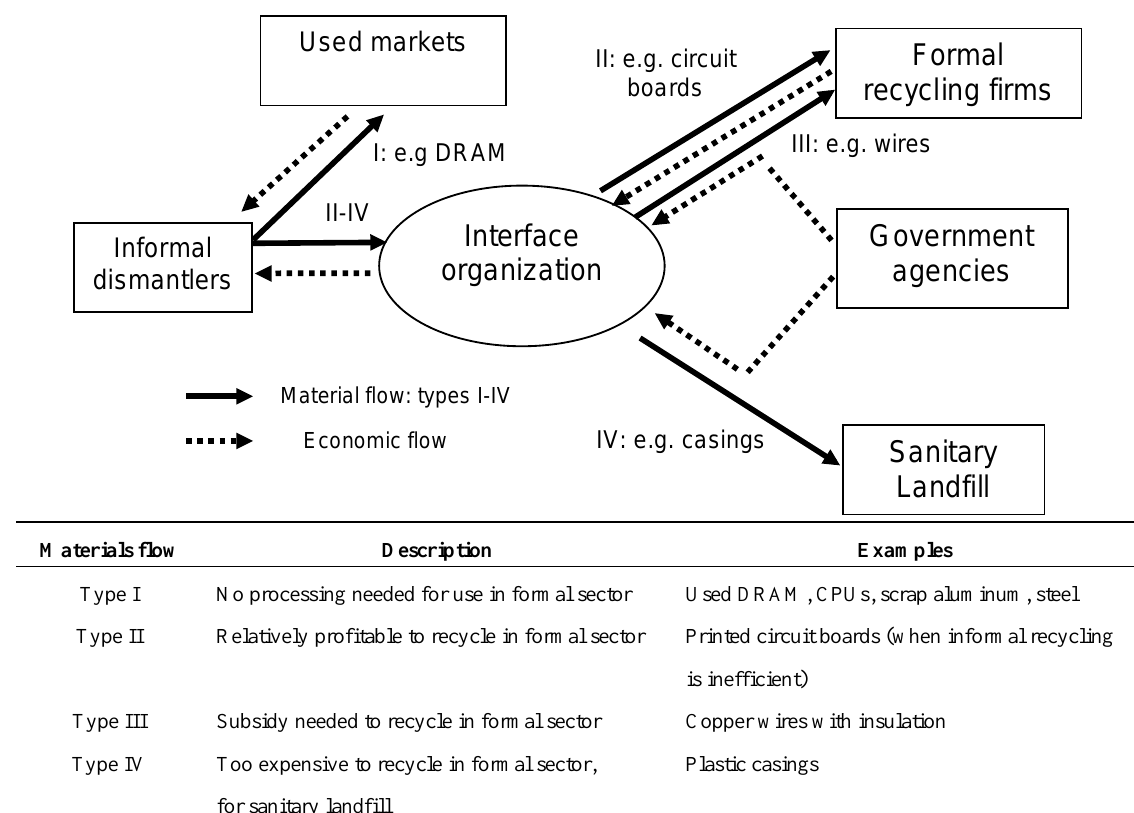
Figure 2. The interface organization as an intermediary between informal and formal